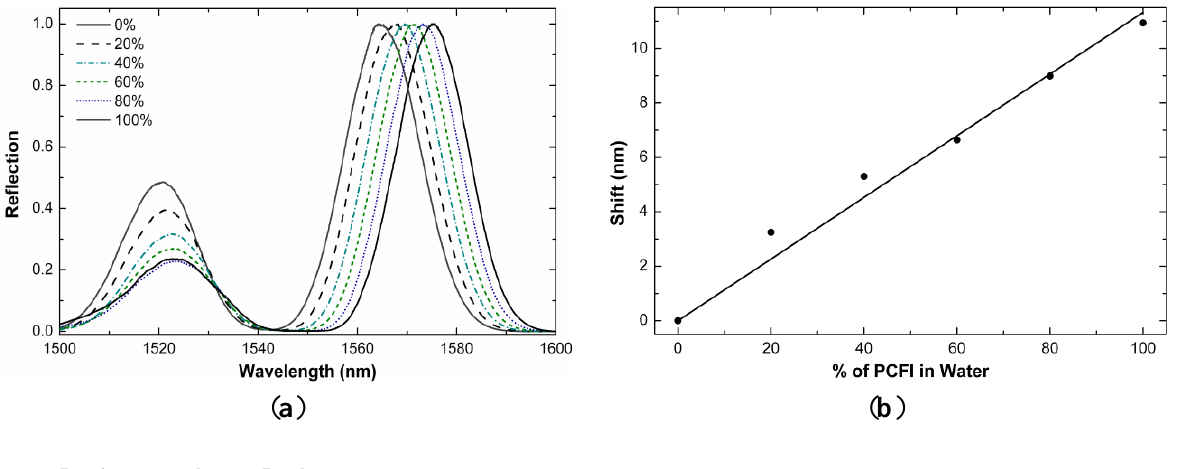
Figure 6. Reflection spectra of an interferometer at different percentages of the length of the PCF immersed in water and the corresponding calibration curve. The PCF length, L, was 11